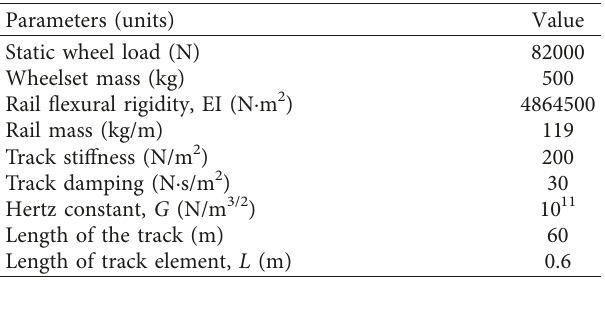
Figure 3: Summary of the two-step integration method. Table 1: Vehicle and track